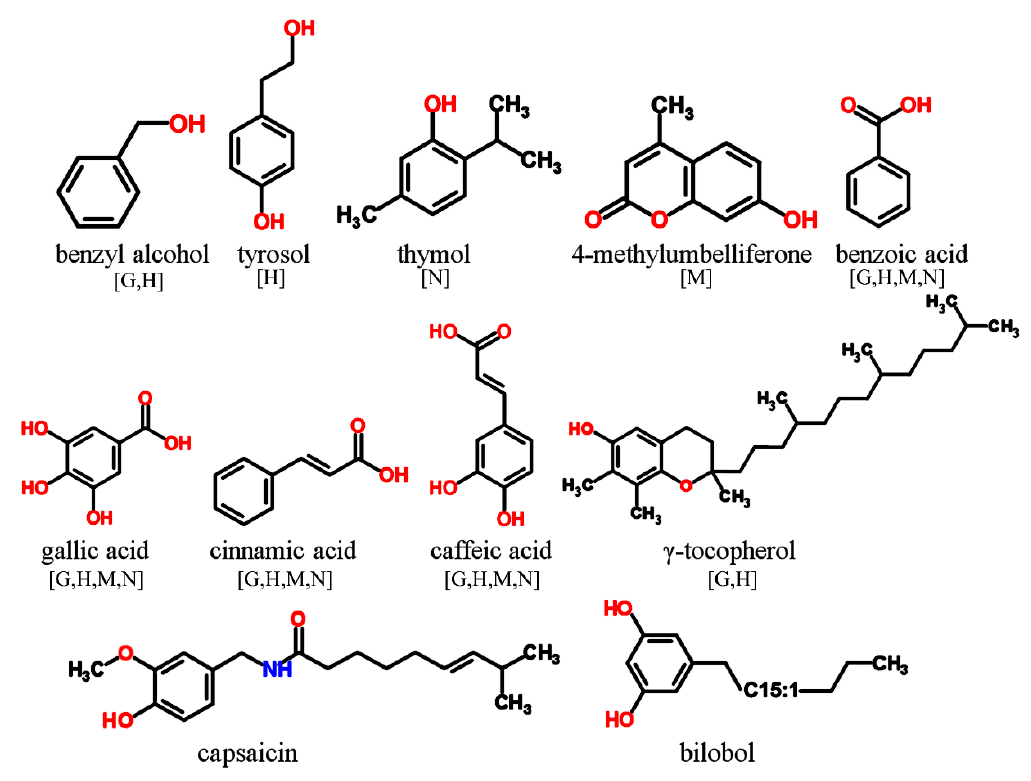
Figure 2. Monophenolics and aromatic acids detectable in GC-MS profiling